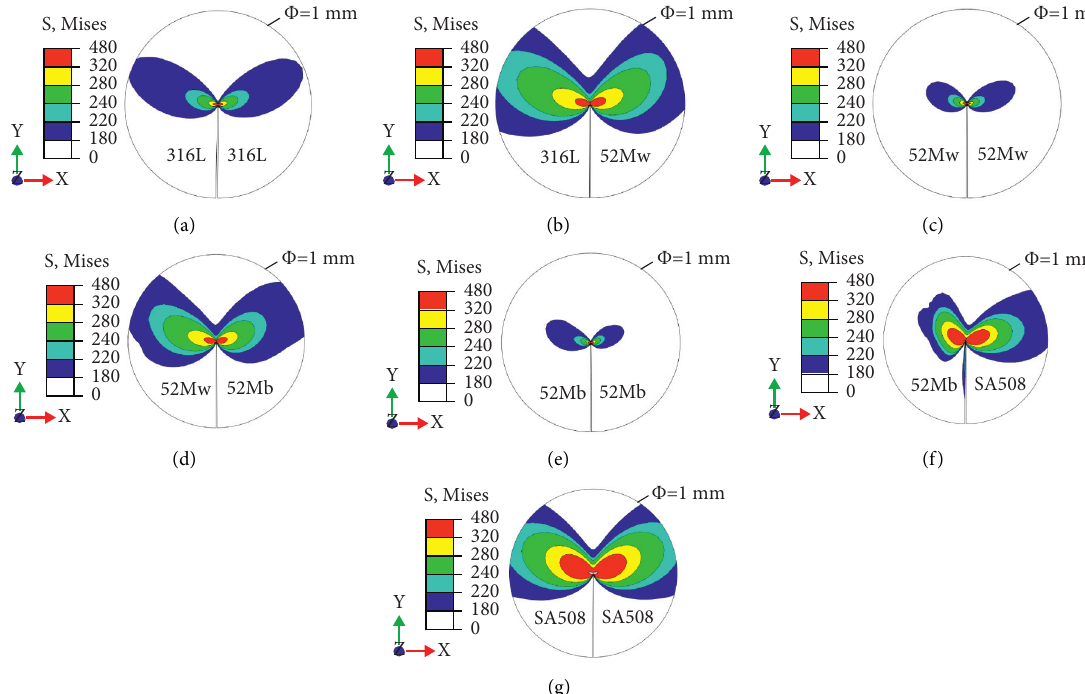
Figure 6: The Mises stress (S, Mises) contour around the crack tip. (a) Crack 1. (b) Crack 2. (c) Crack 3. (d) Crack 4. (e) Crack 5. (f) Crack 6. (g) Crack 7.